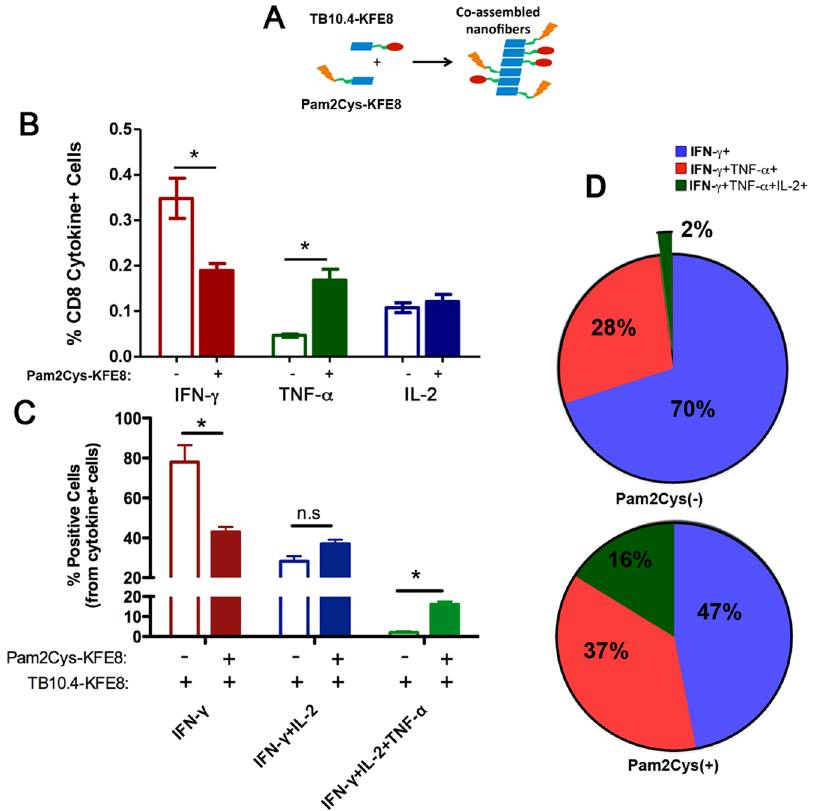
Figure 6. Co-assembled nanofibers of TB10.4 and TLR2 agonist increase the frequency of polyfunctional CD8 + /CD3 + T cells. Schematic shows co-assembly of of TLR-KFE8 and TB10.4-KFE8 into single formulation with a representative electron micrograph ( A ). Lymphocytes were isolated from mediastinal lymph nodes lungs post immunization (foot pad prime and intranasal boost) and stimulated with TB10.4 peptide for 6 hours to induce cytokine expression. Total percentage for each cytokine IFN- γ , TNF- α , and IL-2 from the total population of CD8 + /CD3 + T cells is shown. ( B ) Total percentage of single, double, or triple cytokine positive cells from all cytokine positive cells in the presence or absence of Pam2Cys-KFE8 is shown in panel ( C ). Multifunctional cell populations are significantly higher when Pam2Cys-KFE8 is co-assembled with TB10.4- KFE8. Pie charts are indicate the mean percentages of IFN- γ+ cells that also expressed IL-2, and TNF- α ( D ). N = 4 per group ( B – D ), * p < 0.05 by ANOVA using Tukey post hoc